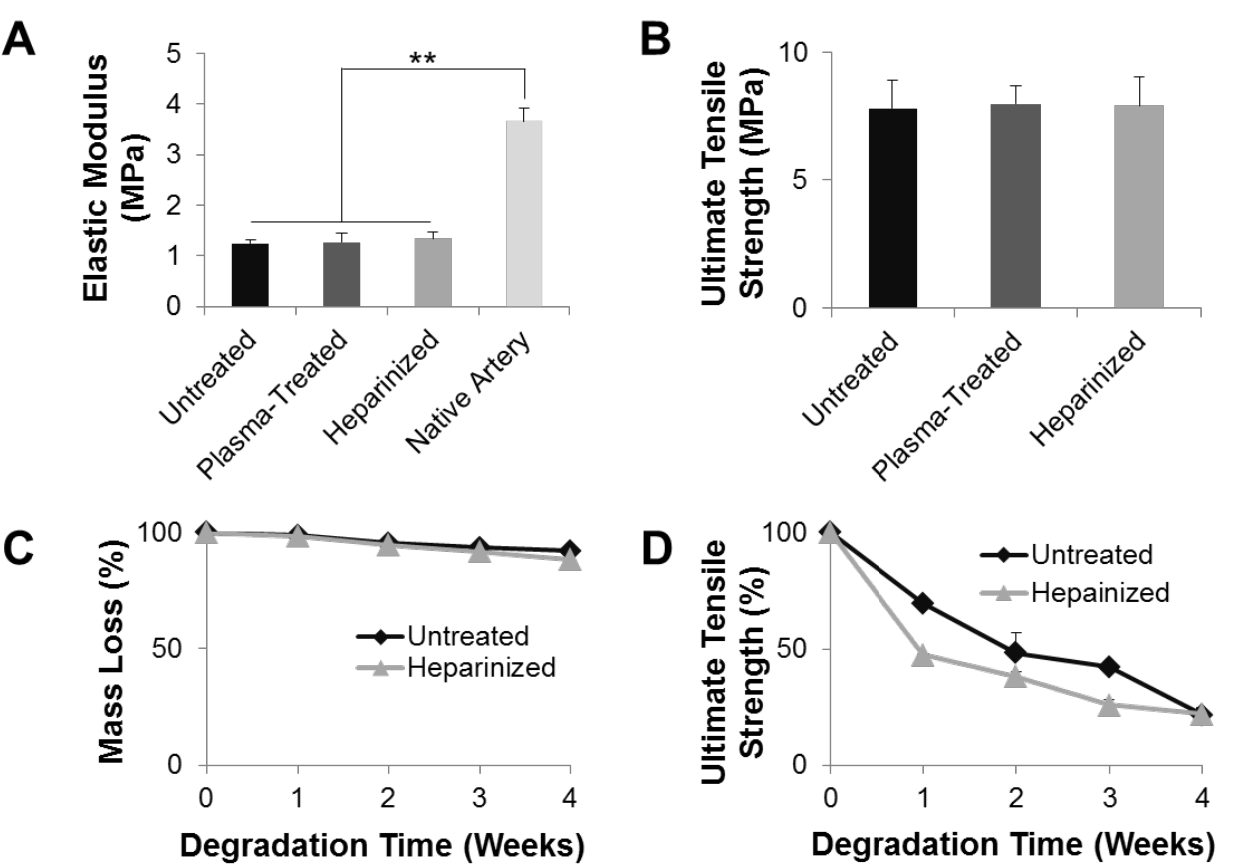
Figure 6. Mechanical and degradation characterization of microfibrous vascular grafts. ( A ) Elastic moduli of untreated, plasma-treated, heparinized vascular grafts, and native common carotid arteries. ( B ) UTS of untreated, plasma-treated, and heparinized vascular grafts. ( C ) Mass loss of untreated and heparinized vascular grafts during 4 weeks of hydrolysis in PBS under constant agitation. ( D ) Changes in the UTS of untreated and heparinized vascular grafts during 4 weeks of hydrolysis in PBS under constant agitation. ** p < 0.01, ( n = 3).